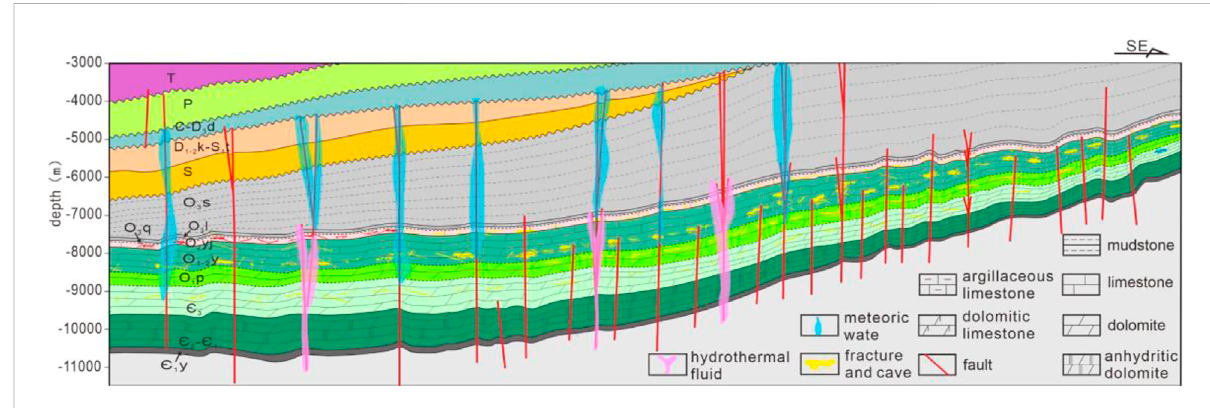
FIGURE 8 Patterns of hydrocarbon accumulation related to strike-slip faults in Tarim